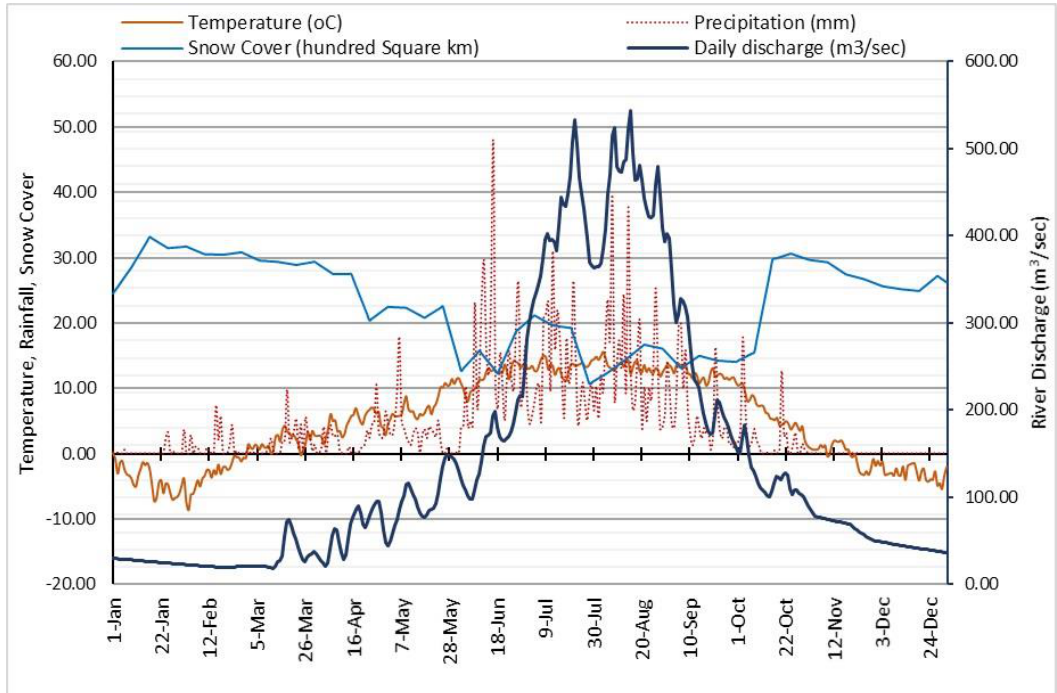
Figure 4. Snow cover fraction (SCF) variation among different zones derived from moderate resolution imaging spectroradiometer (MODIS) eight-day snow cover product MOD10A2 from the year 2005 to 2018.